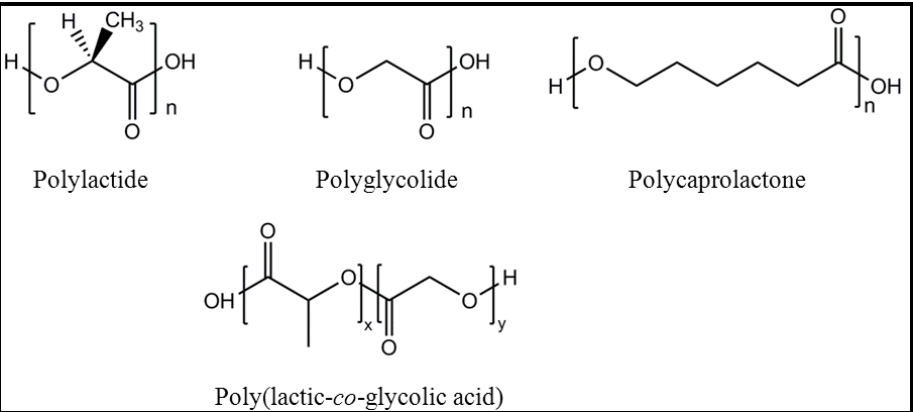
Figure 1. Scheme showing the chemical structure of main biodegradable polymer used in